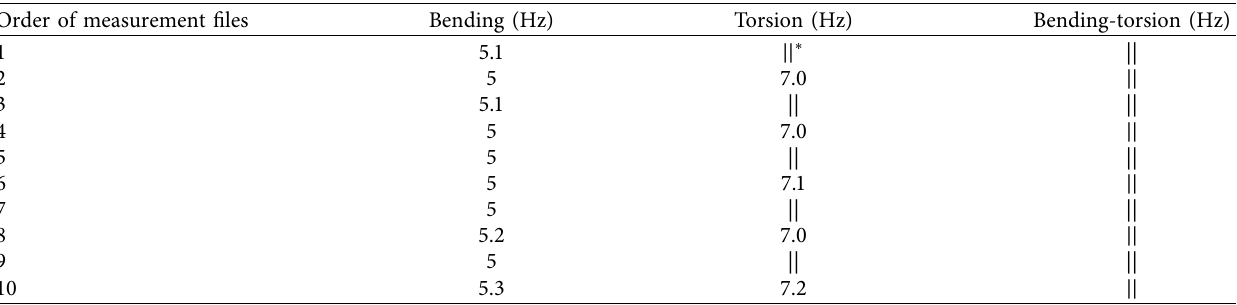
Figure 15: The changing process of two close frequencies. Table 2: Statistics of frequencies of Ben Noc bridge (obtained from LAM).